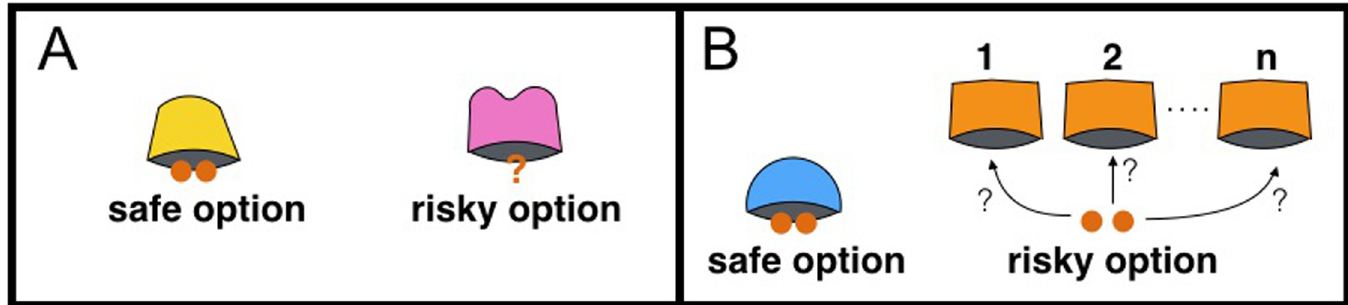
Fig 1. ’Single cup’ design and ’multiple cups’ design. Apparatus for the ’single cup’ design (A) as used in [24], leading to risk-aversion or weak risk-proneness. Subjects have to choose between one safe cup and one risky cup yielding an unknown amount of reward, with an unknown probability of yield. Apparatus for the ’multiple cups’ design (B) as used in [40], leading to high risk-proneness. Subjects have to choose between one safe cup and one to four risky cups, where only one risky cup contains the reward.